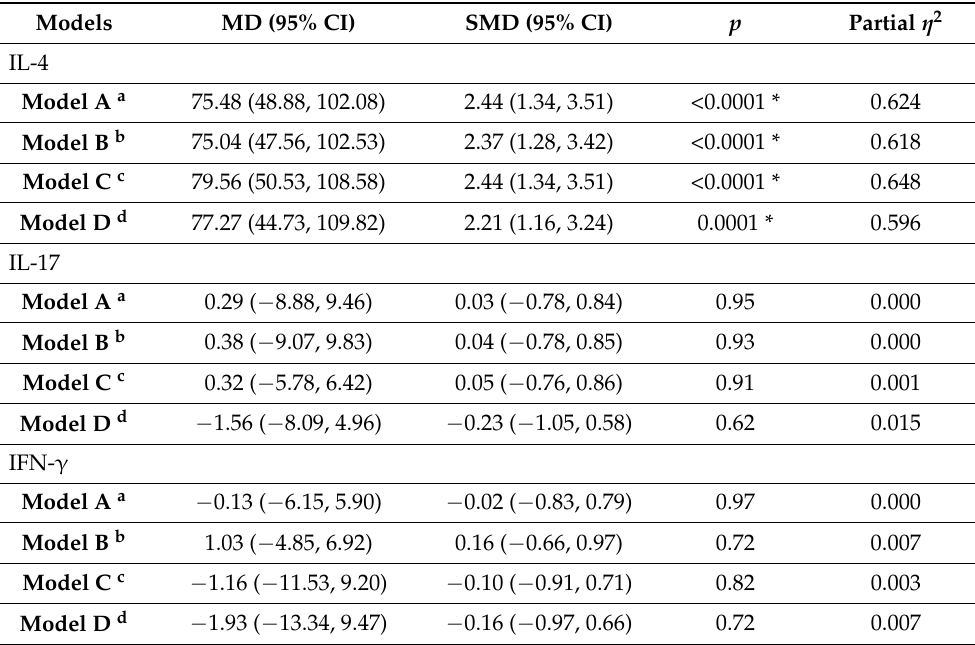
Table 3. The effectiveness of β -glucan ointment on cytokines